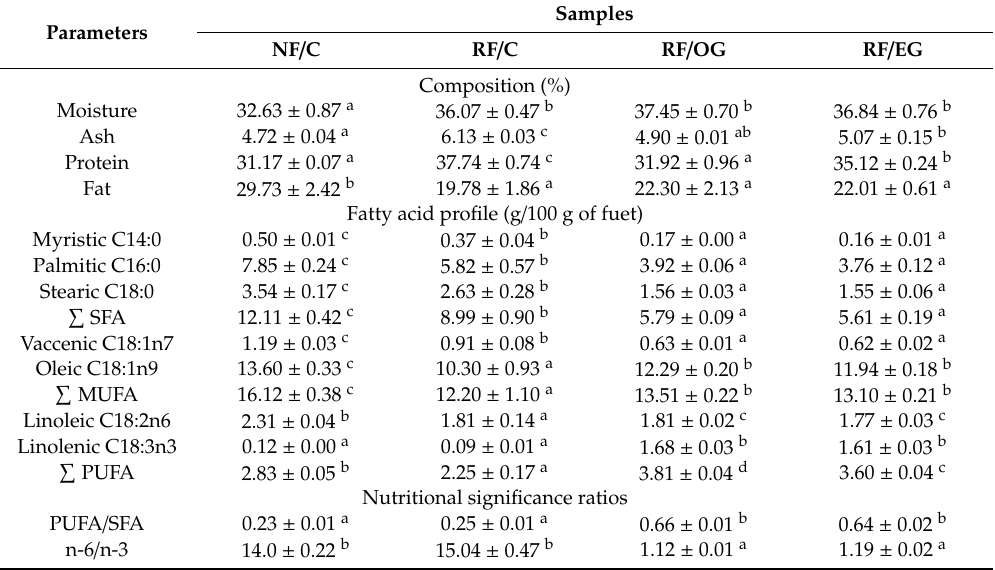
Table 2. Chemical compositions and nutritional significance ratios of di ff erent fuets after the ripening